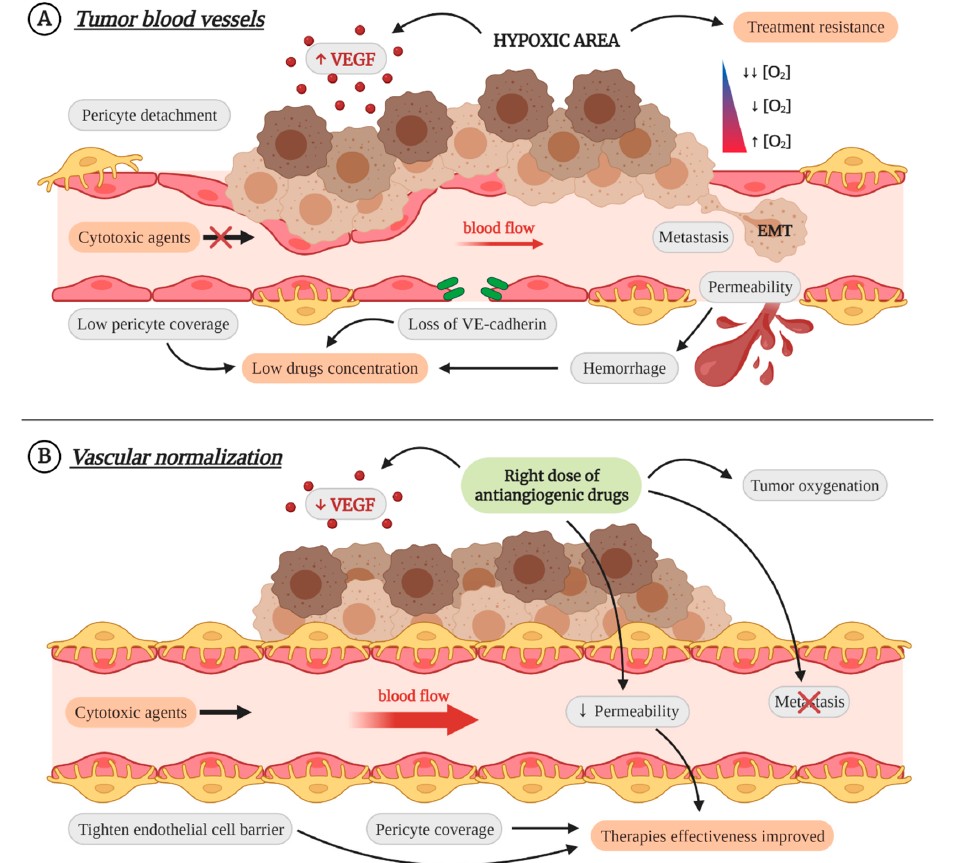
Figure 3. Characteristics and consequences of immature tumor blood vessels, and the effect of vascular normalization as a therapeutic strategy. ( A ) Tumor blood vessels. Tumor vasculature is abnormal and with less mural coverage, which increases vascular permeability and leads to the apparition of hemorrhages. The uncontrolled proliferation of tumor cells causes increased hypoxia and allows their intravasation and metastasis. Moreover, the hypoxic microenvironment and permeability prevent the arrival of drugs and cytotoxic agents to large tumor areas and favor the appearance of treatment resistances. ( B ) Vascular normalization . The use of the right dose of antiangiogenic drugs avoids blood vessels abnormality, which improves blood flow, reduces hypoxia and permeability, and allows the activity of cytotoxic agents. In consequence, therapy effectiveness is improved and, moreover, it prevents intravasation of tumor cells and metastases. Created with